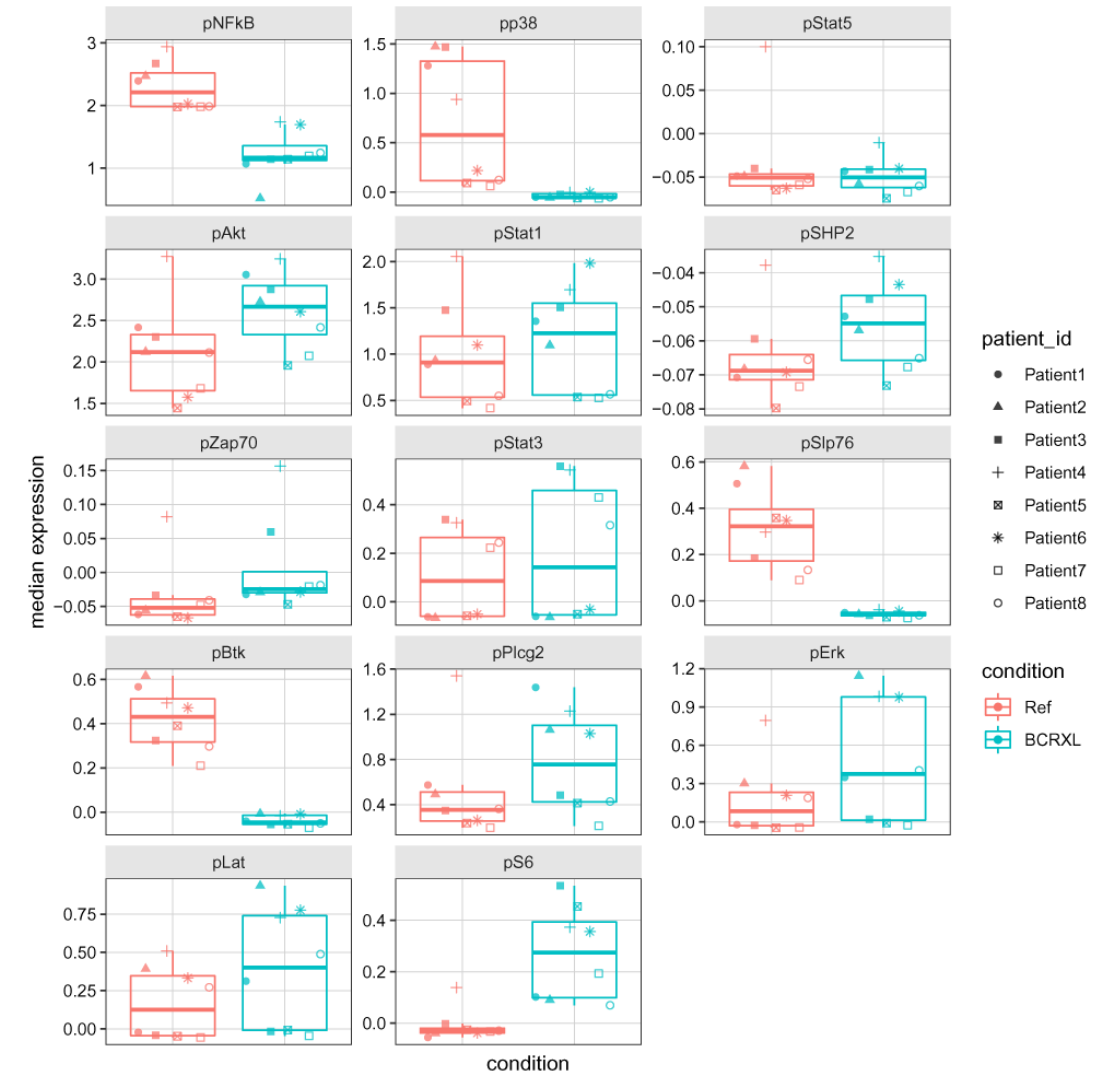
Figure 25. Median (arcsinh-transformed) expression of 14 signaling markers calculated from all the cells in a given sample in the PBMC dataset. Values for the two conditions are indicated with different colors: red for the unstimulated (Ref) and blue for the stimulated with BCR/FcR-XL (BCRXL) samples. Values for each patient are indicated with different shape.